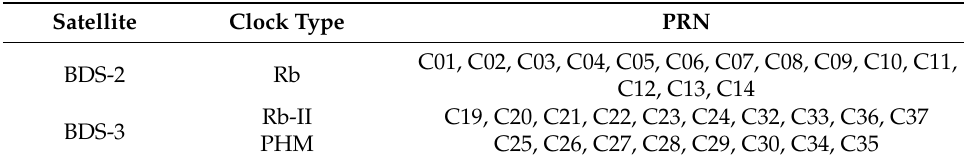
Table 1. Types of BDS satellite atomic clocks used in this work.